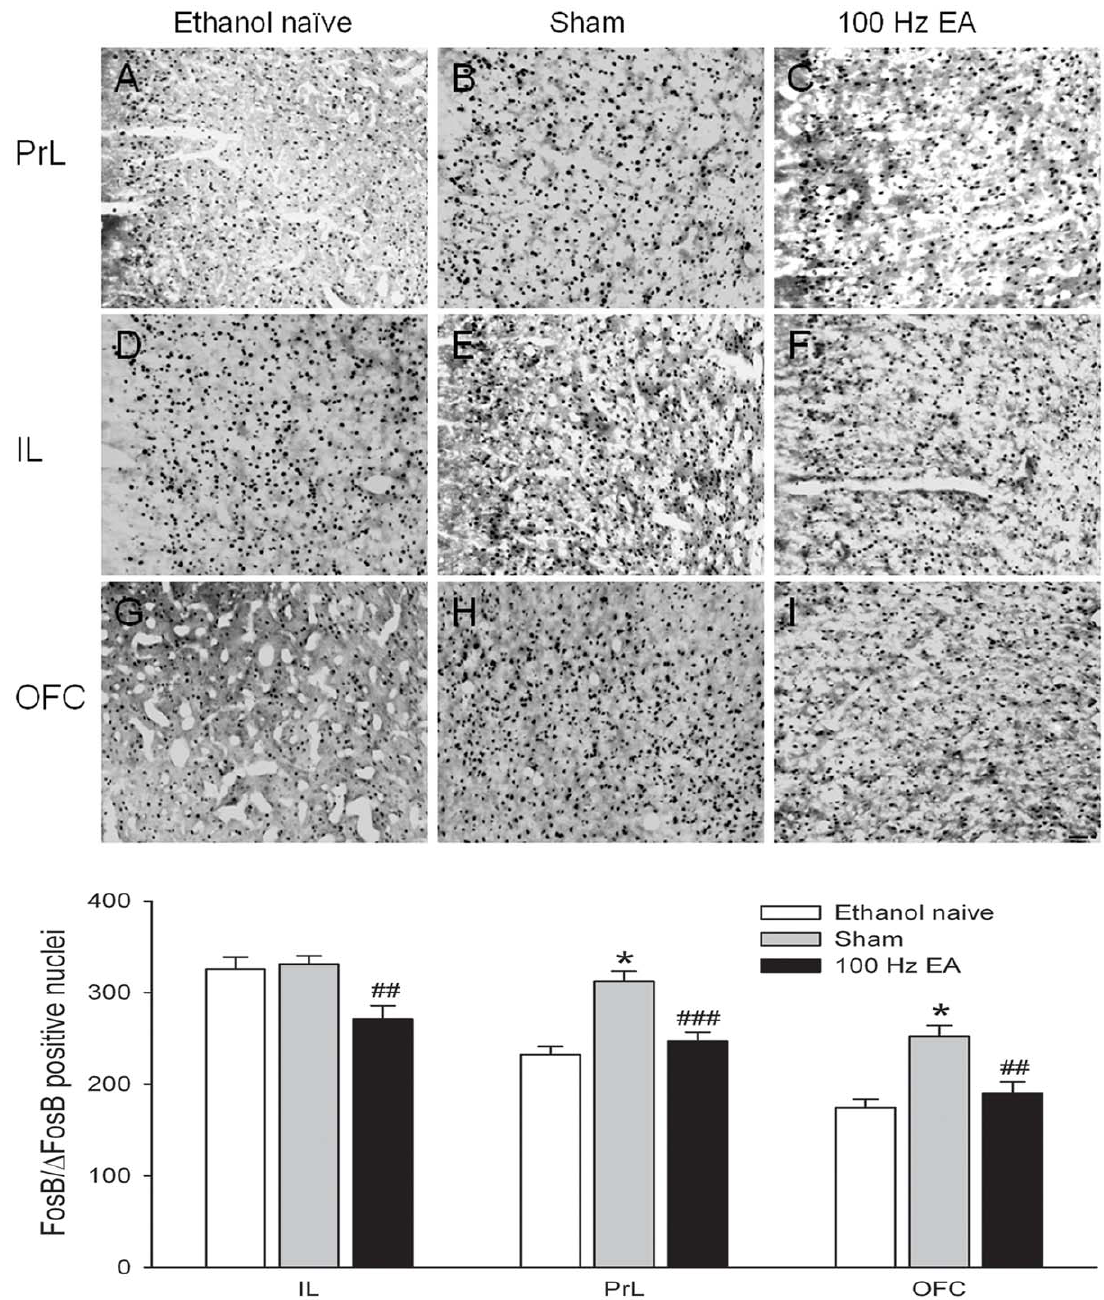
Figure 7. Photomicrographs depicting typical brain regions of analysis for the prelimbic (PrL), infralimbic (IL) and the orbitofrontal cortex (OFC) divisions of the prefrontal cortex. Panels indicate FosB/ D FosB-positive cells in animals that were drinking water (ethanol naı¨ve, A, D and G ), drinking large amounts of ethanol treated with sham ( B, E and H ), and drinking large amounts of ethanol treated with multiple high frequency EA ( C, F and I ). Increased numbers of FosB/ D FosB-positive cells were observed in the PrL and OFC, but not in the IL in rats that chronically consumed large amounts of ethanol with sham treatment, as compared with ethanol naive animals. Multiple sessions of 100 Hz EA significantly decreased the numbers of FosB/ D FosB positive nuclei in the IL, PrL and OFC in rats that consumed large amounts of ethanol. Data are expressed as mean 6 S.E.M. * indicates significant difference from ethanol naı¨ve ( p , 0.001); ## p , 0.01, ### p , 0.001 indicates a significant difference from sham. Scale bar=100 m